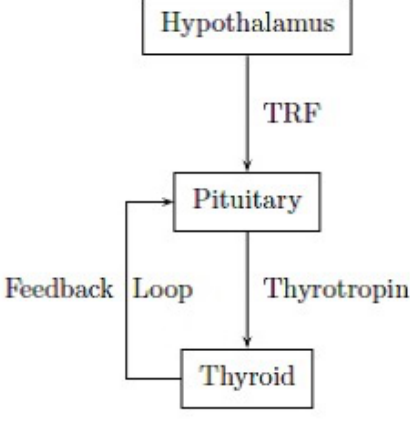
Figure 1. Thyroid-pituitary